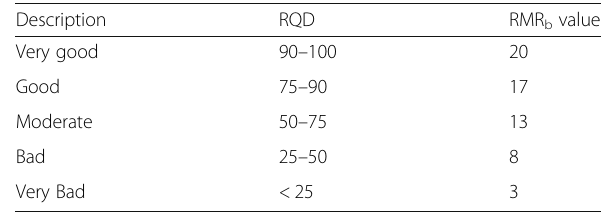
Table 1 Uniaxial Compressive Strength (UCS) classification